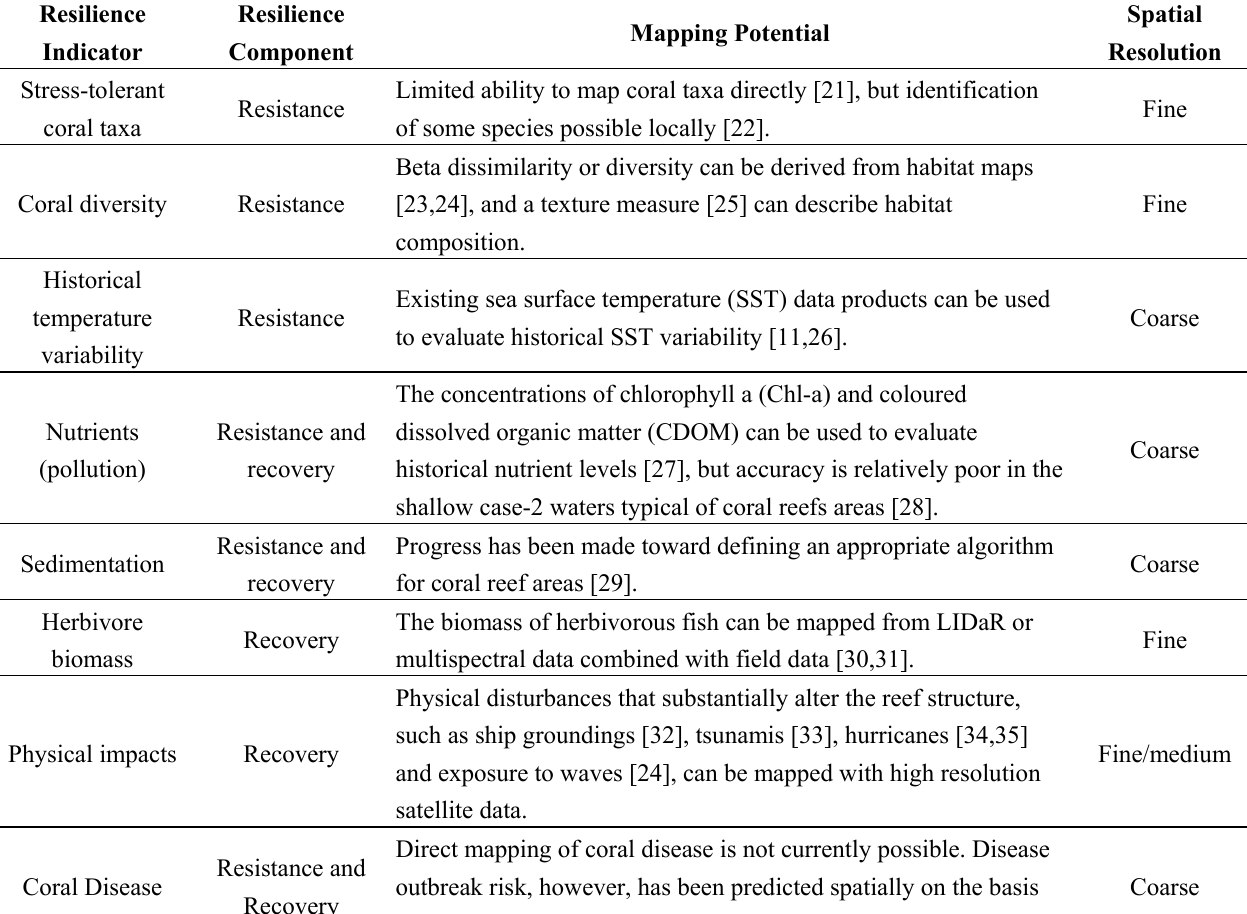
Table 1. Key coral reef resilience indicators identified through expert review [18]. The spatial resolution at which each can be mapped is indicated as “fine” (<5 m pixel size, e.g., IKONOS, QuickBird, WorldView-2), “medium” (5–100 m pixel size, e.g., Landsat) or “coarse” (>100 m pixel size, e.g., AVHRR, MERIS, MODIS, AATSR or